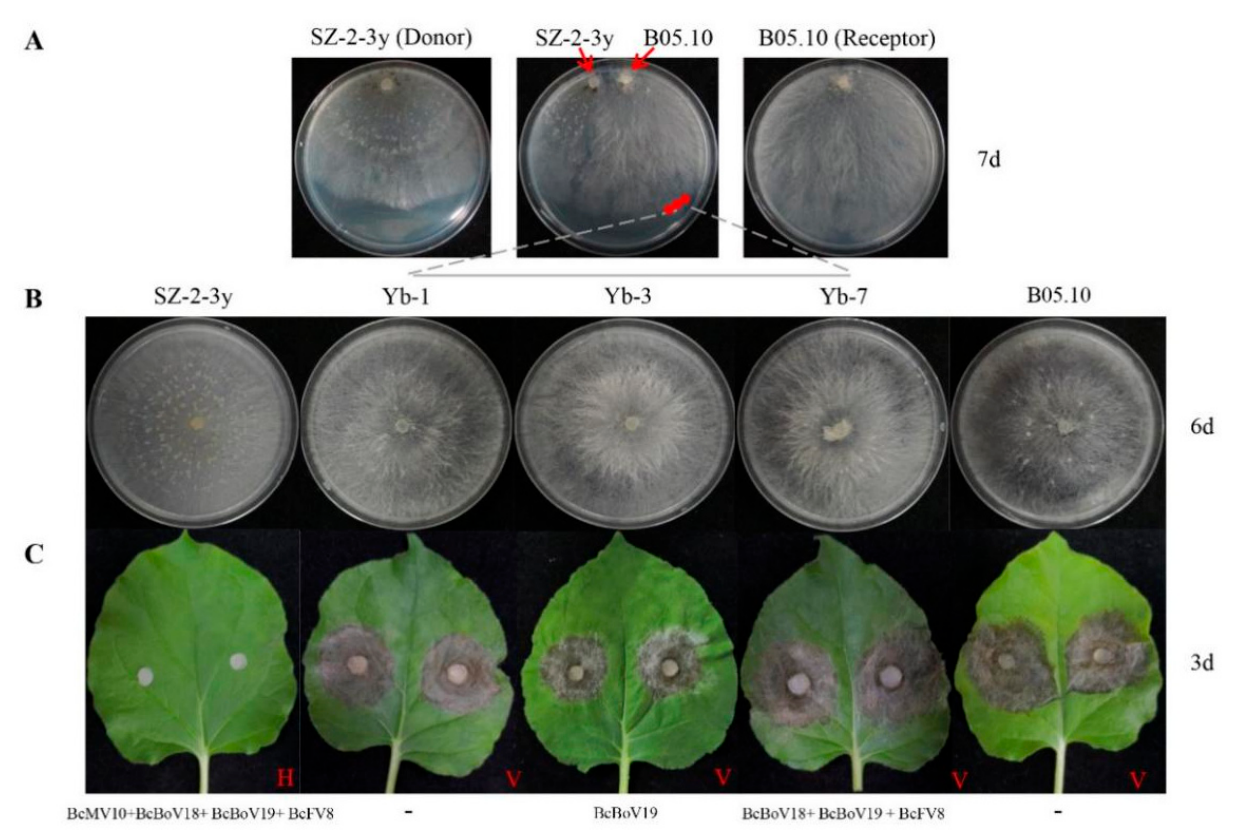
Figure 7. Horizontal transmission of mycoviruses through hyphal contact in paired cultures on PDA: ( A ) paired cultures after 7 days on PDA with colonies of strain SZ-2-3y as donor and strain B05.10 as receipt. Red circles indicate the area where a mycelial agar plug was removed and transferred to PDA for derivatives (Yb-1, Yb-3 and Yb-7); ( B ) colony phenotypes of the three representative derivatives on PDA (20 ◦ C) after 6 days; ( C ) pathogenicity of derivatives (Yb-1, Yb-3 and Yb-7) on detached leaves of tobacco (20 ◦ C, 3 days). H = Hypovirulence; V = Virulence. ‘-’ indicates no mycovirus detection. Table 2. Horizontal transmission of mycoviruses from SZ-2-3y to B05.10.